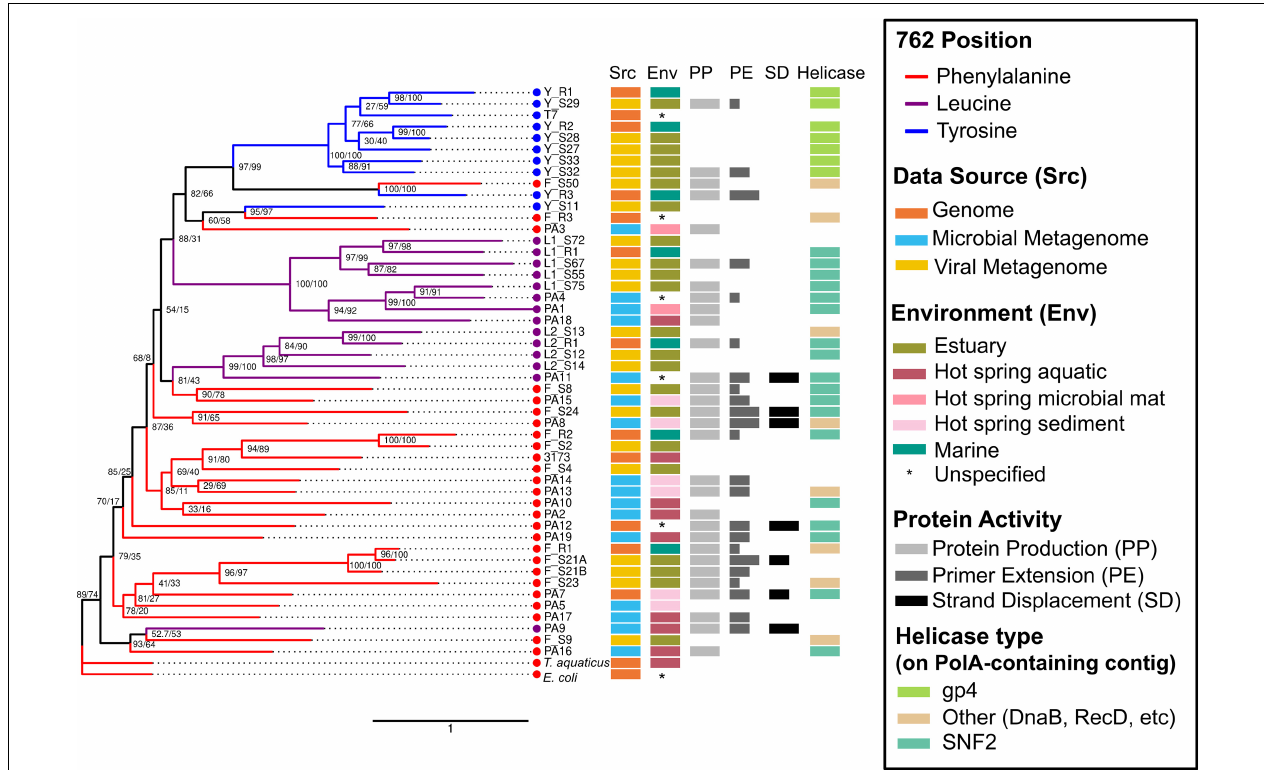
FIGURE 2 | Synthesized family A DNA polymerase sequences produce proteins with diverse biochemistry. Maximum likelihood tree of four biochemically characterized references ( E. coli , T. aquaticus , T7, and 3173) and 48 synthesized family A DNA polymerase amino acid sequences trimmed to the region of interest (DNA_pol_A Superfamily, acc. cl02626). Synthesized reference, viral metagenome (virome), and microbial metagenome sequences are labeled by 762 residue group (phenylalanine F) or clade (leucine, L1 or L2, or tyrosine, Y). The strength of primer extension (PE) and strand displacement (SD) activities are reflected in the bar lengths. Node values represent ultrafast bootstrap support (UFBoot) and Shimodaira-Hasegawa approximate likelihood ratio test (SH-aLRT), respectively. Scale bar represents the number of amino acid substitutions per